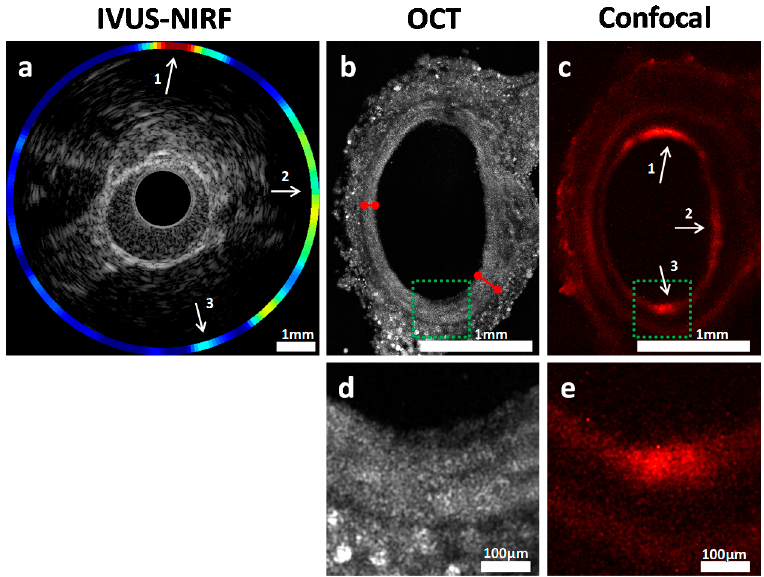
Figure 7. Cross-sectional view of the abdominal aorta in model 2. ( a ) IVUS-NIRF imaging in vivo; ( b ) OCT imaging ex vivo; ( c ) Confocal fluorescence microscopy imaging ex vivo; ( d , e ) Enlarged sections of the green region of ( b , c ). Red arrows identify the intimal thickness at two locations in the OCT image. White arrows indicate colocalization between in vivo and ex vivo fluorescence. Arrow 3 shows a weaker colocalization due to the limitation of our blood attenuation compensation algorithm [19], further supporting the need for co-registered ex vivo validation.